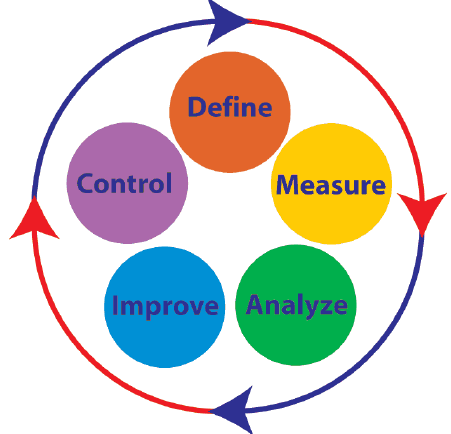
Figure 3. DMAIC cycle of improvement.